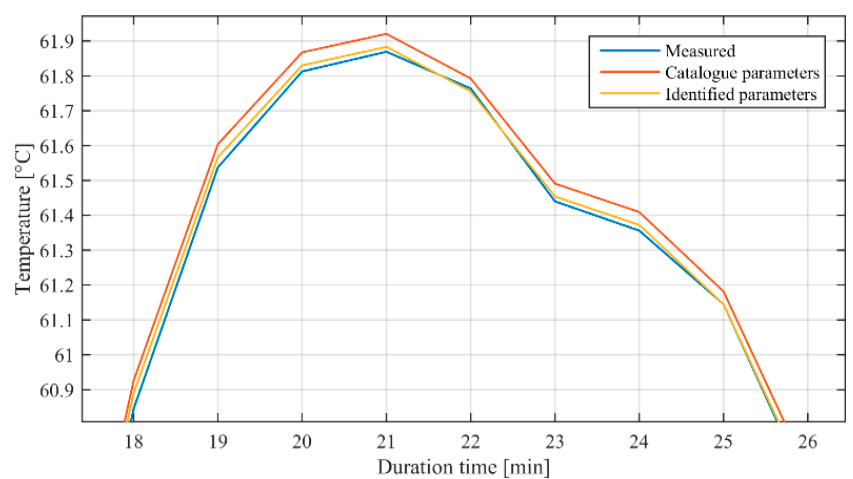
Figure 6. Measured (blue line) and model calculated temperature using catalogue parameters (red line) and parameters determined by the proposed optimization procedure (yellow line) at the conductor temperature 60 °C for the conductor AlFe 240/40.